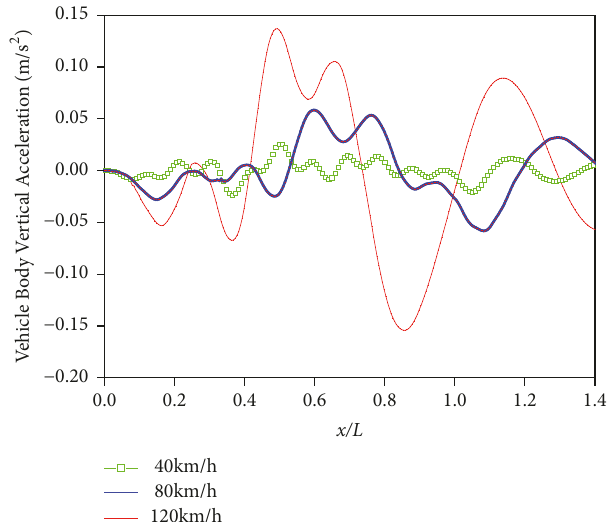
Figure 9: Vertical acceleration of vehicle body with different speed.